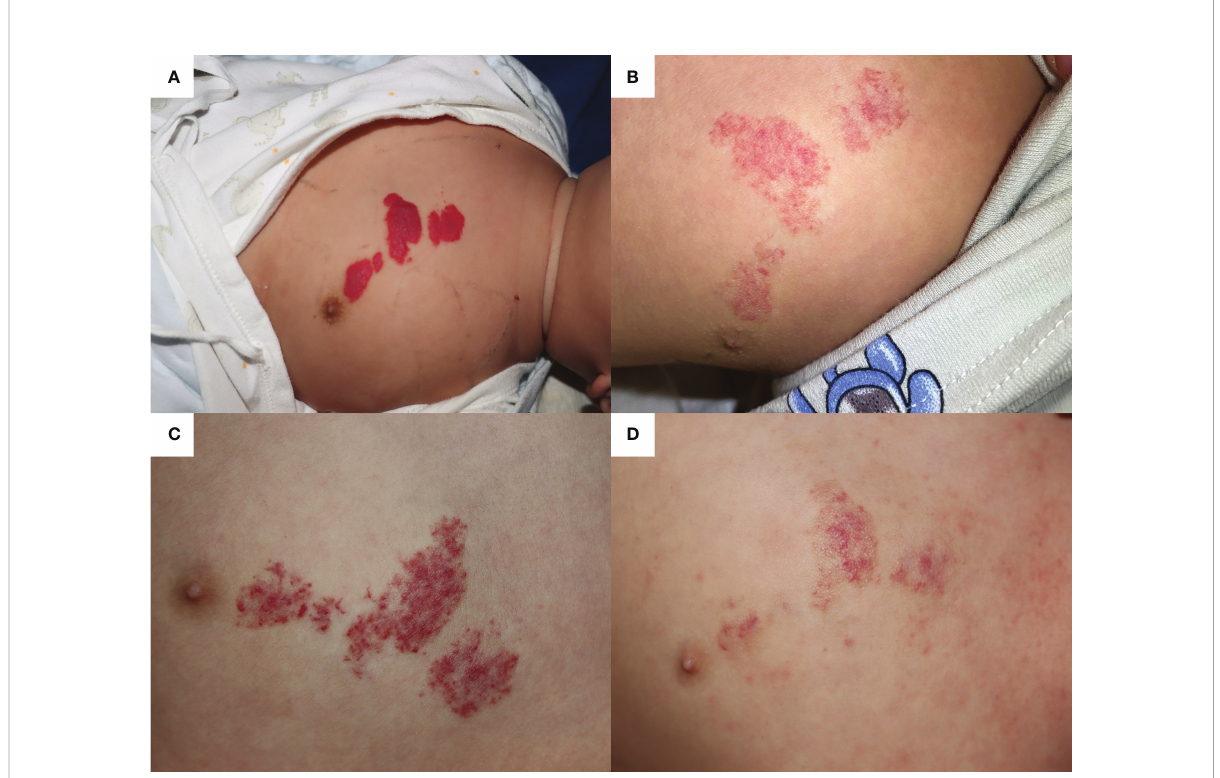
FIGURE 1 The infantile hemangioma in patient 1 at different periods. (A) Proliferating infantile hemangioma before oral propranolol therapy. (B) Involuted infantile hemangioma when the patient was admitted for pneumonia at the age of 13 months. (C) Infantile hemangioma worsened after nearly 1 day of oral procaterol therapy. (D) Involuted hemangioma after 1 month of oral propranolol therapy and one laser